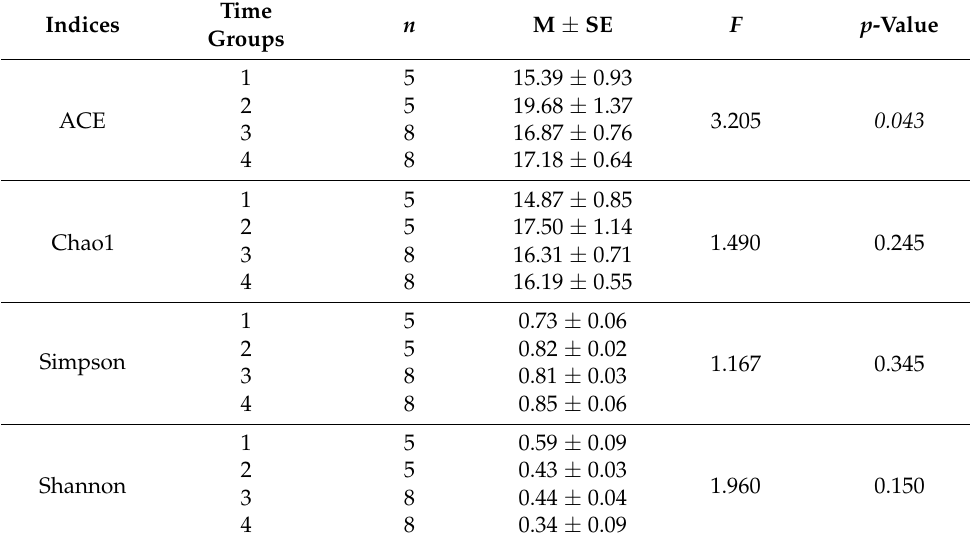
Table 5. Results of one-way ANOVA for the effect of different seasons on bacterial community diversity of Pseudoregma bambucicola